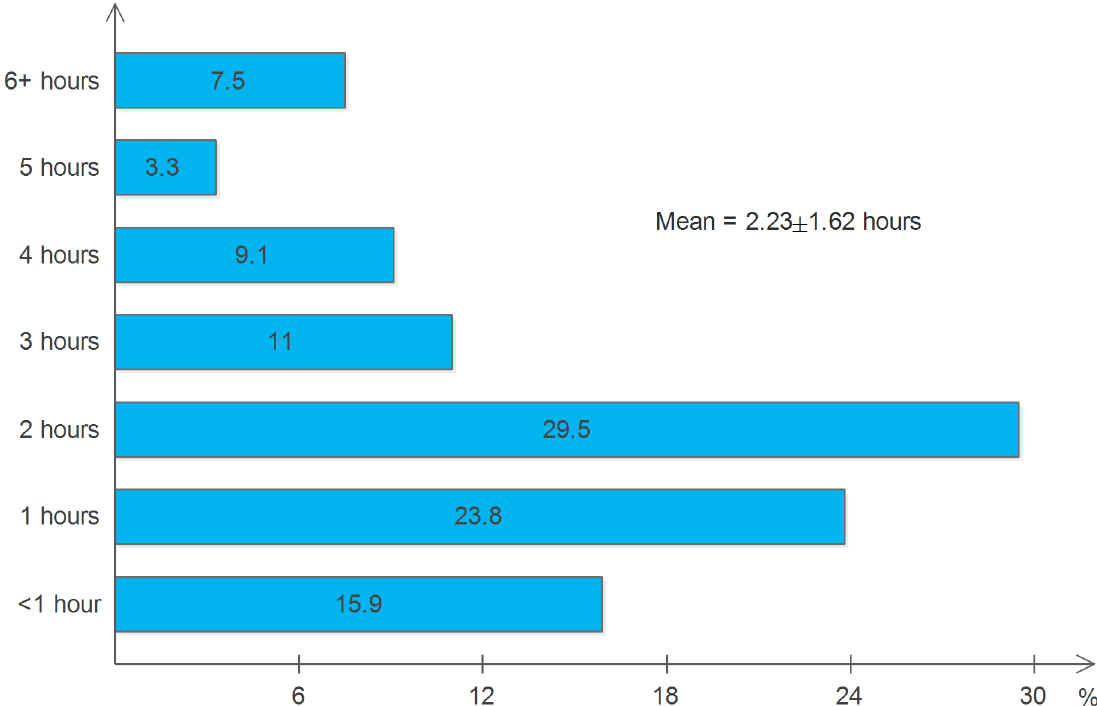
Fig 1. Number of hours spent to obtain care as reported by the